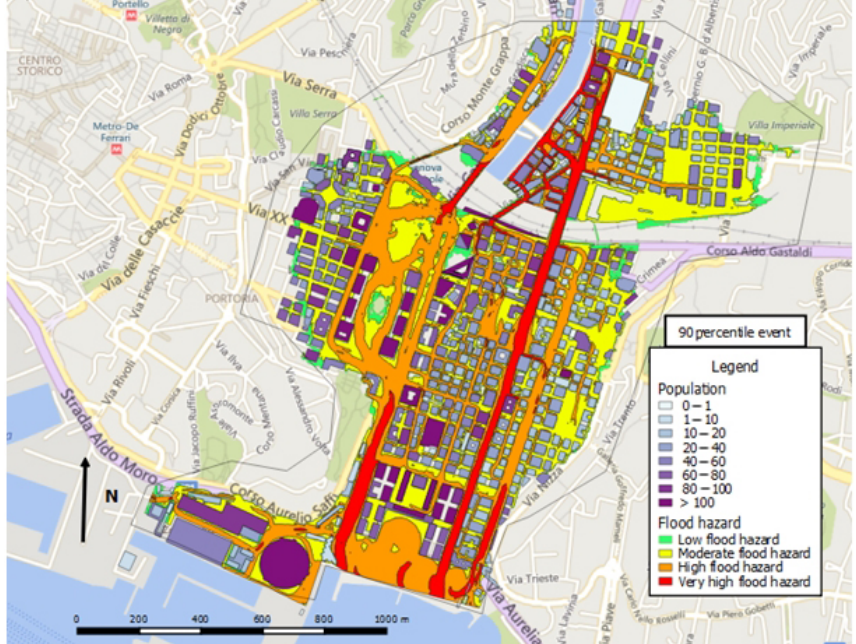
Figure 14. Perc90 scenario, hazard level map compared with population potentially involved assigned to each building.